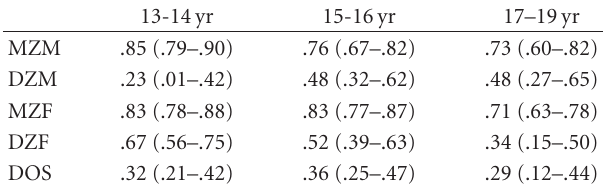
Table 3: Twin correlations for exercise participation in each age group (95% confidence intervals added in